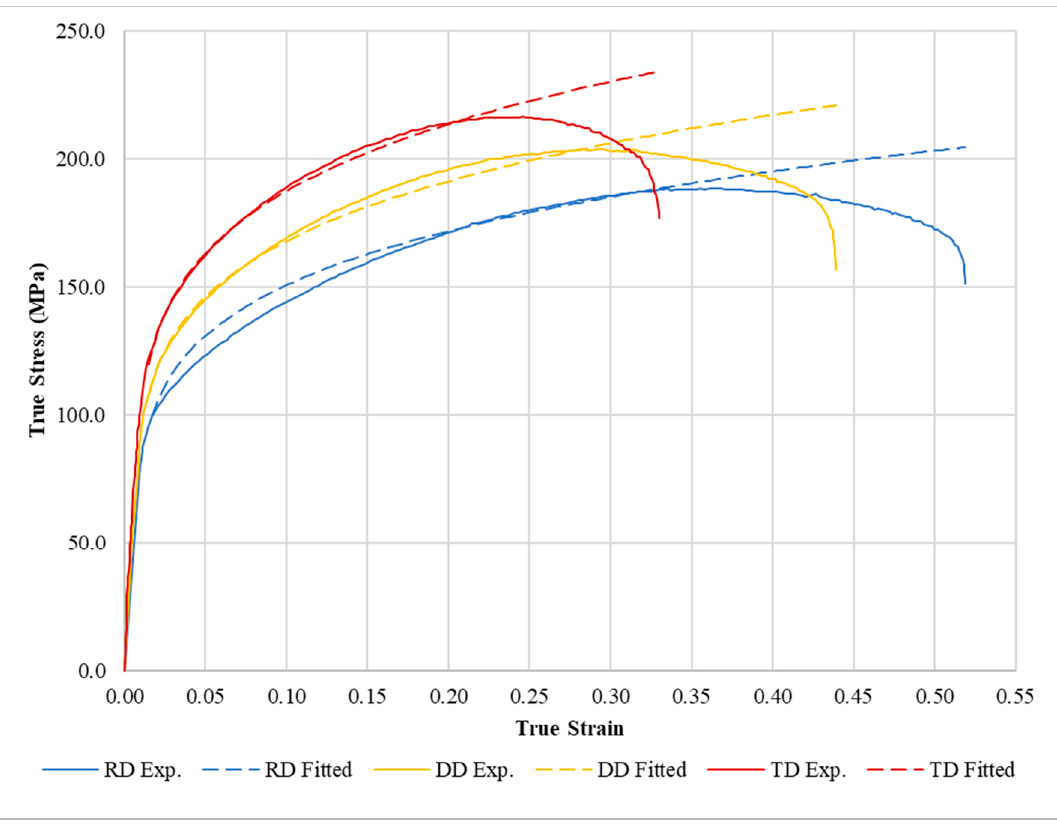
Figure 4. Experimental and adjusted true stress-strain tensile curves (for all cases, the fitted curves are plotted in the whole range of strain until fracture).